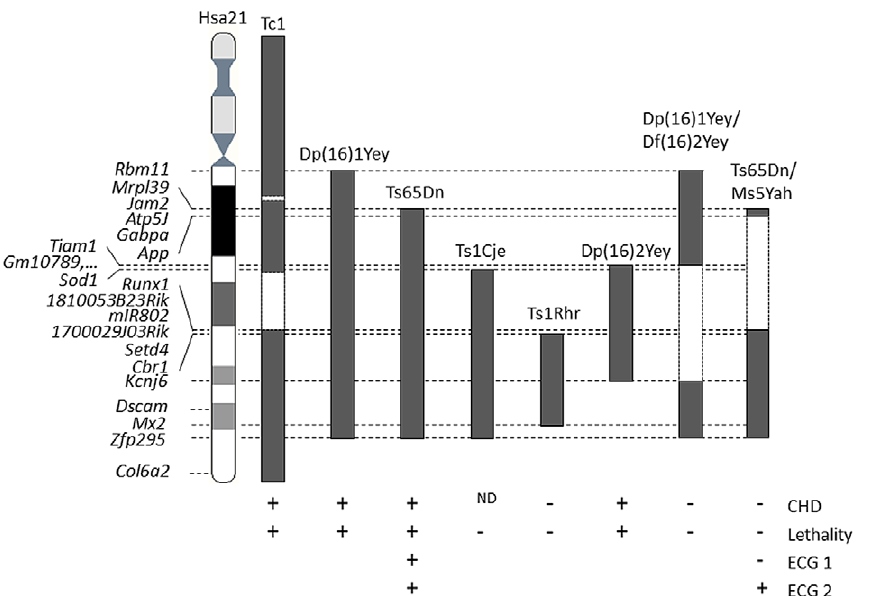
Figure 7. Representation of the DS mouse models displaying lethality and cardiac features. The position of the trisomic segment with the homologous regions to Hsa21, or the Hsa21 regions found in Tc1, is indicated in grey black blocks. While the disomic segments in compound mutants Dp(16)1Yey/Df(16)2Yey or in Ts65Dn/Ms5Yah or the deleted segments in Tc1 are indicated in dashed boxes. ‘‘ + ’’ indicates the presence and ‘‘ 2 ’’ the absence of phenotypes whereas ND indicates a non-determined state for presence or absence of CHD in Ts1Cje. References are given in the text.